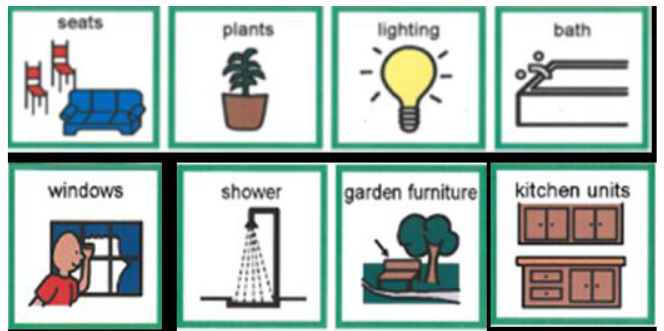
Figure 5. Talking Mat symbols (Options) for Elements. The Picture Communication Symbols ©1981–2012 Dynavox Mayer Johnson are used with permission. All rights reserved worldwide.